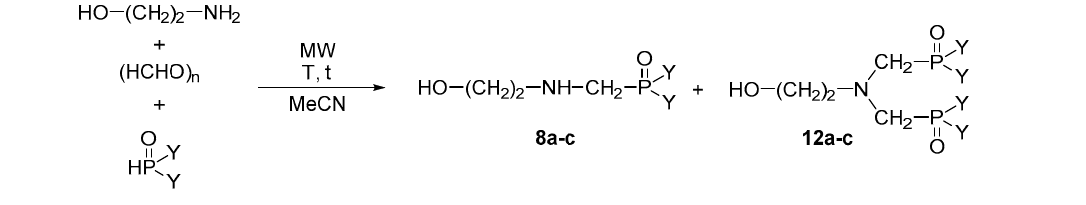
Table 5. Double Kabachnik – Fields reaction of ethanolamine using excess of the paraformaldehyde and the secondary phosphine oxides.